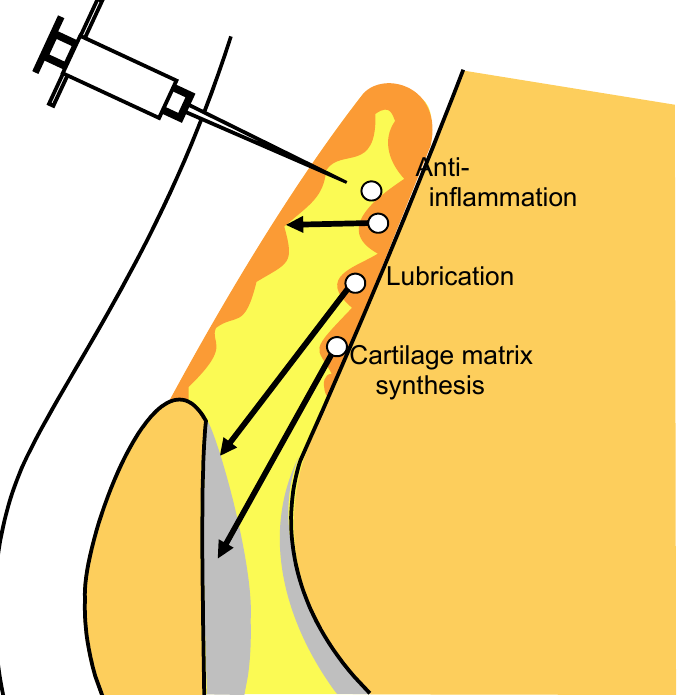
Figure 9. Mode of action in synovial MSC injection therapy for OA. Synovial MSCs injected into the knee joint migrate to the synovium and maintain the properties of MSCs. Synovial MSCs promote anti-inflammation, lubrication, and cartilage matrix synthesis. Consequently, synovial MSC injections inhibit the progression of OA.